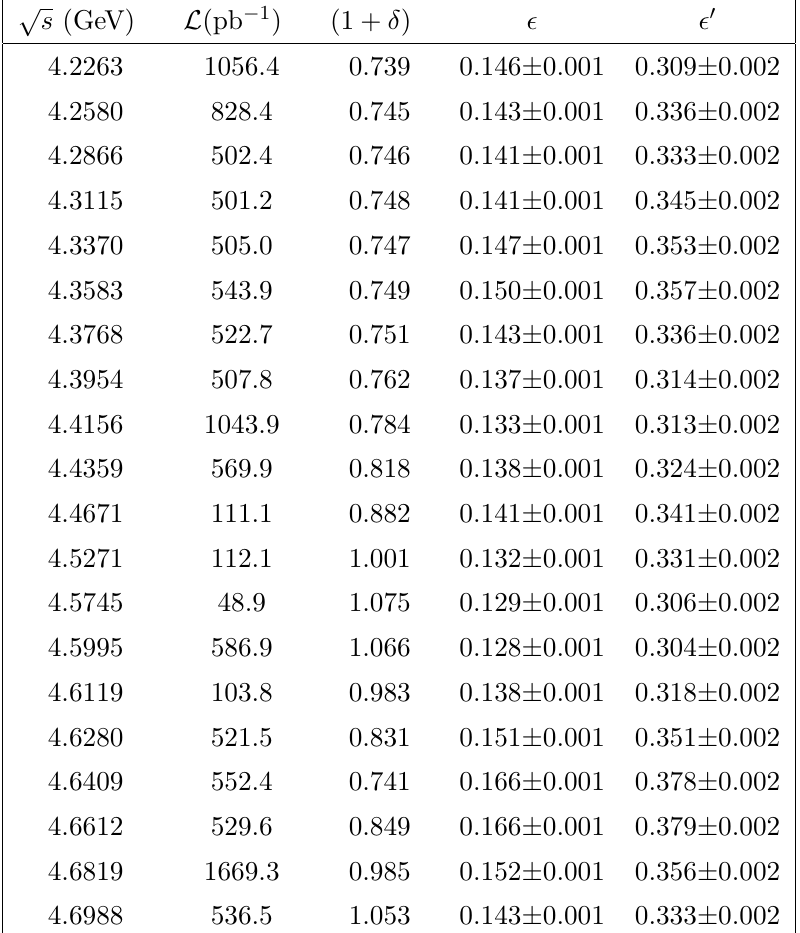
Table 1 . The luminosity [19–21], radiative correction factor and efficiency at each CM energy for the e + e − → π 0 π 0 ψ 2 (3823) process. The efficiency for the e + e − → π + π − ψ 2 (3823) process ( (cid:15) 0 ) is also quoted [10]. The uncertainty on (cid:15)/(cid:15) 0 is related to the MC sample size.